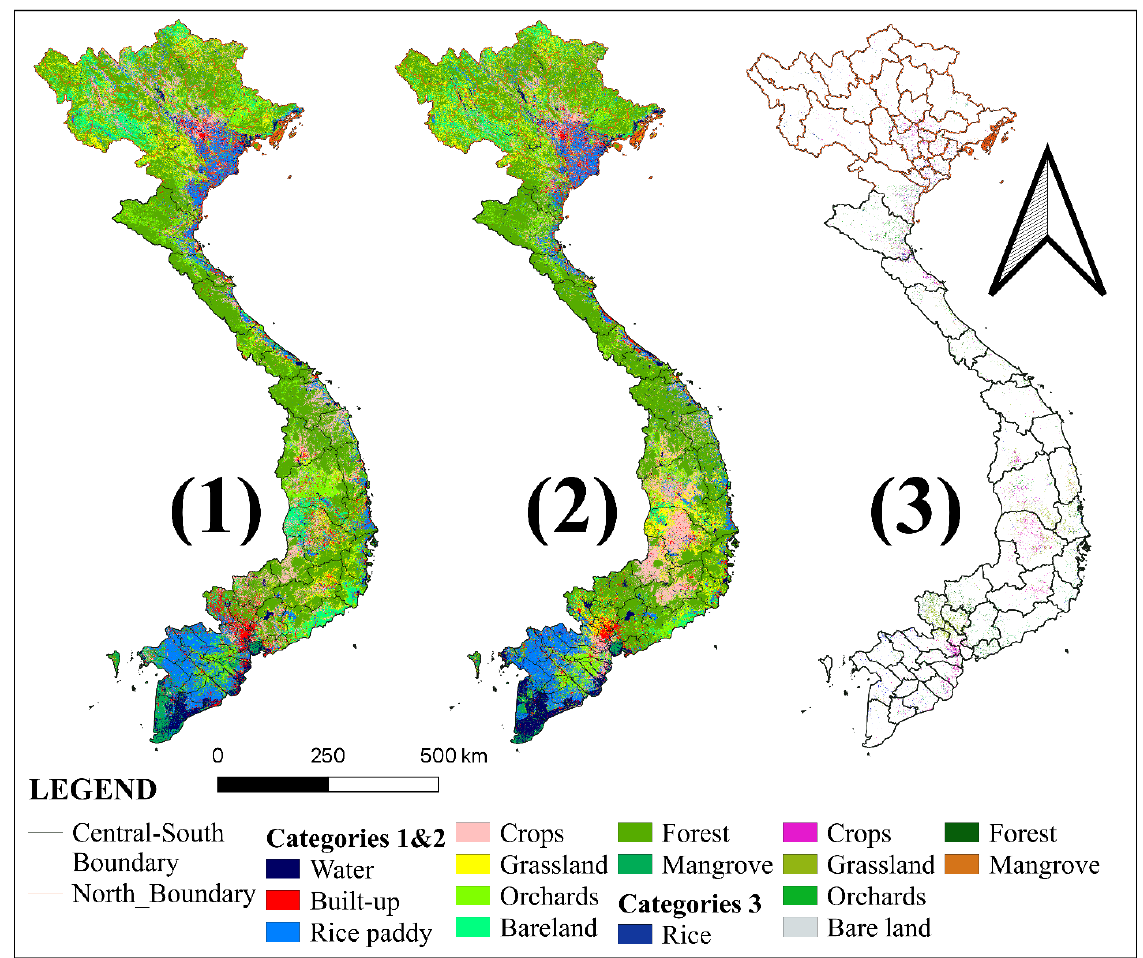
Fig. 4. Land Cover and Land Cover Change in Vietnam (2007, 2015 and 2017) (Source: Author’s complication from JAXA): (1) – Land cover map of 2007; (2) – Land cover map of 2015 in the North and 2017 in the Central and South; (3) – Map of land cover change from agricultural categories to built-up land according to spatial